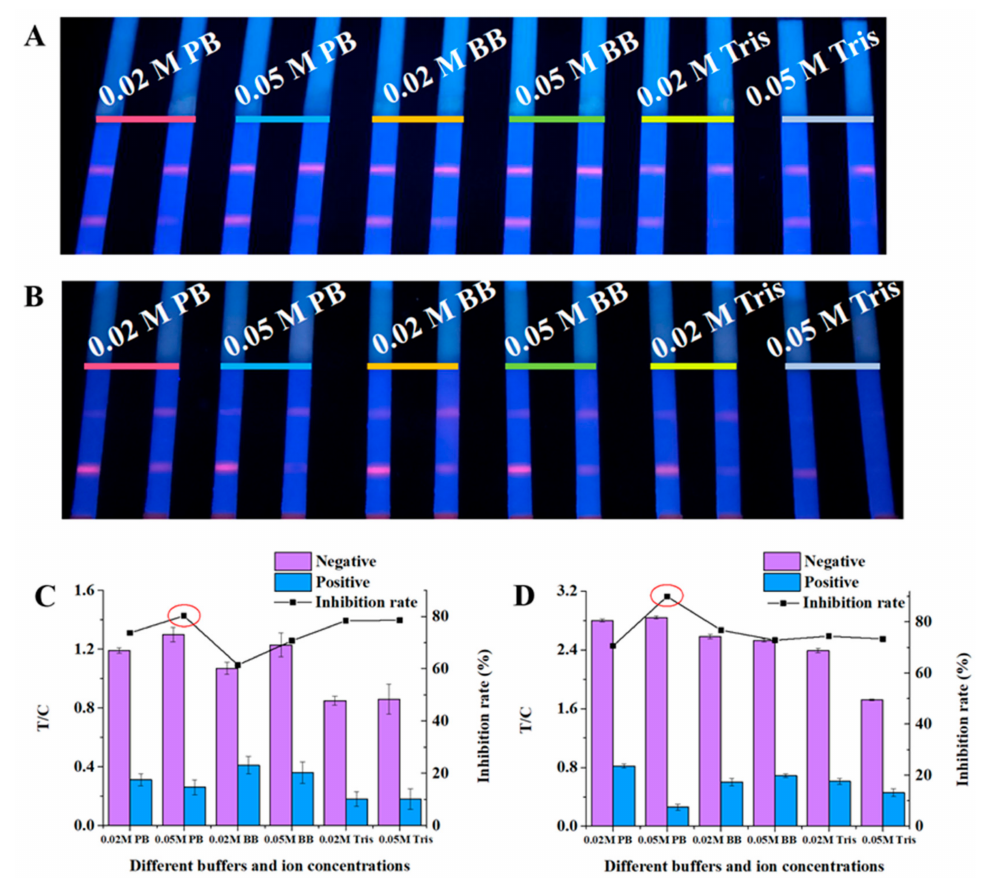
Figure 3. The fluorescence intensity, inhibition effect, and inhibition rate results of the sample pad treatment buffer: ( A ) ultraviolet lamp results for milk detection; ( B ) ultraviolet lamp results for pork detection; ( C ) fluorescence quantitative results for milk detection; and ( D ) fluorescence quantitative results for pork